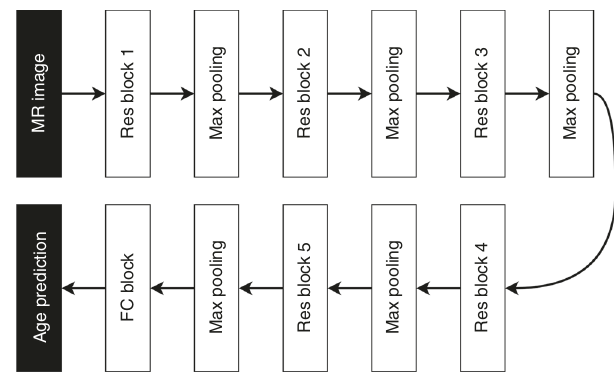
Fig. 3 A fl owchart showing the components of the proposed CNN architecture. Residual (Res), fully connected (FC).